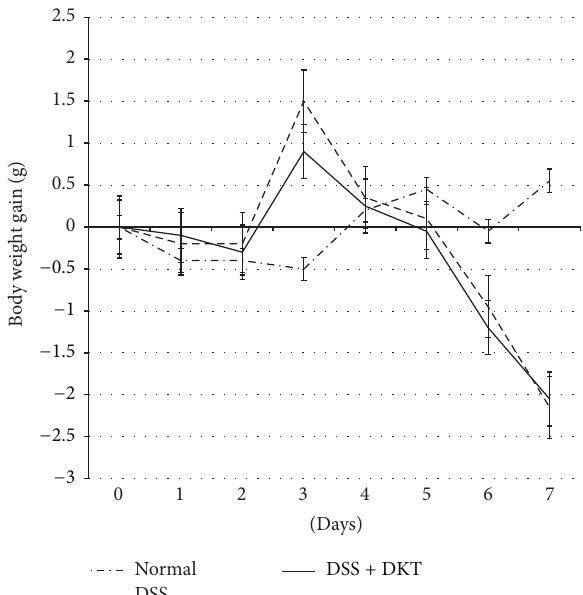
Figure 1: Body weight gain of each study group. Normal group, untreated mice. Dextran sulfate sodium (DSS) group, mice provided with 5% DSS for 7 days. DSS + daikenchuto (DKT) group, mice provided with DKT in addition to DSS. 𝑛 = 10 mice (for normal, DSS, and DSS + DKT